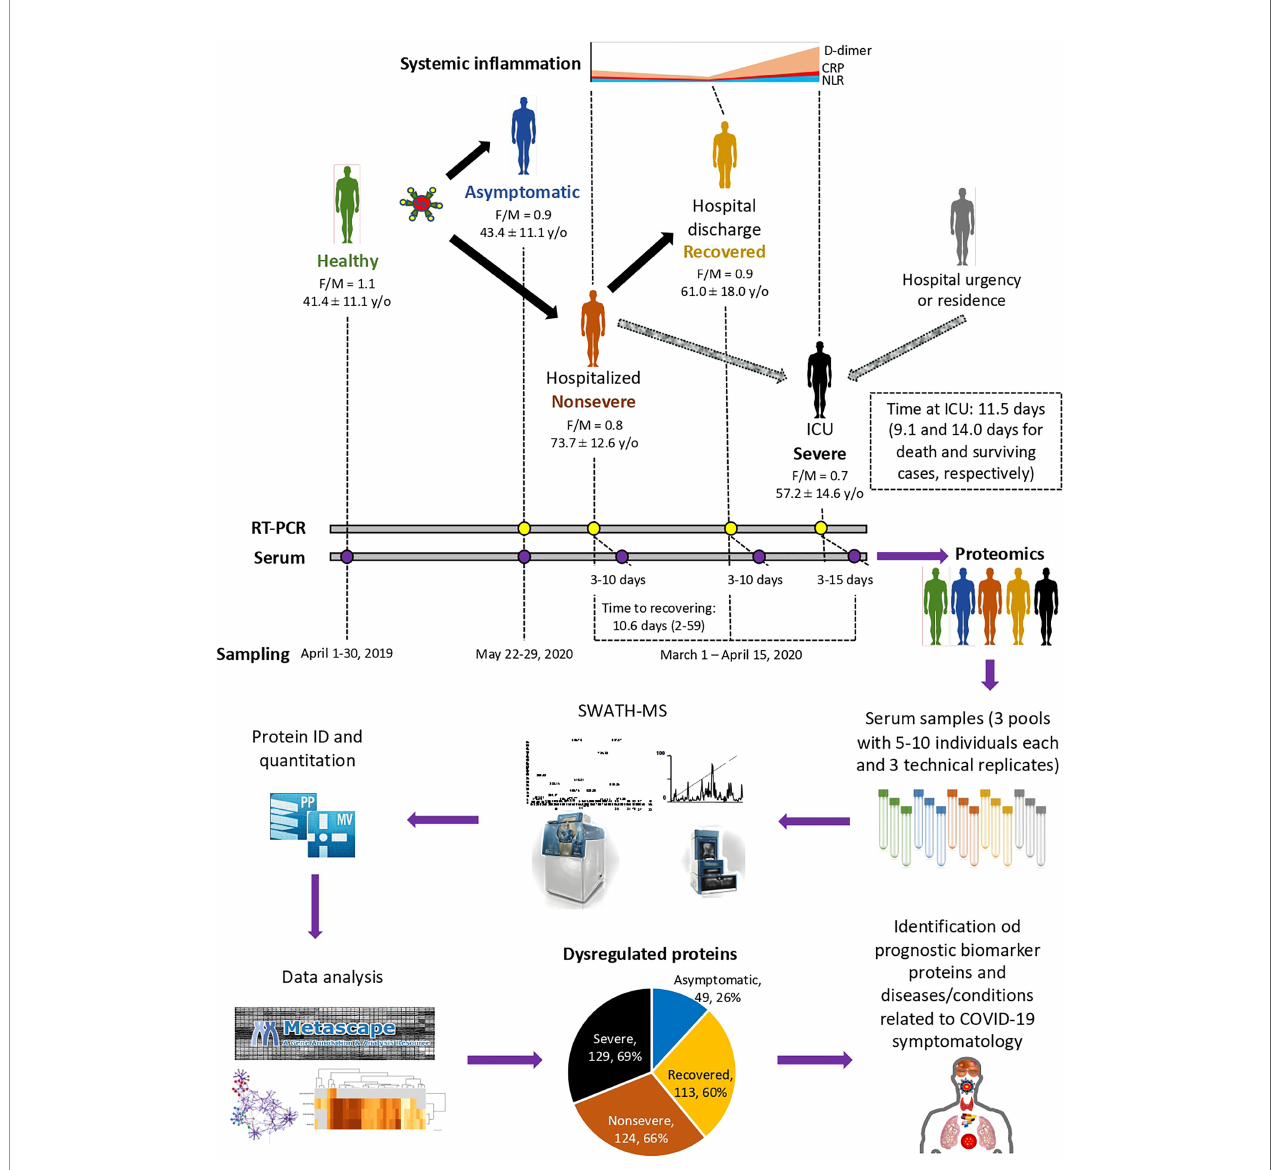
FIGURE 1 | Individual cohorts and study design. COVID-19 patients included cohorts of asymptomatic ( n = 16), recovered (hospital discharge; n = 26), nonsevere (hospitalized; n = 28), and severe (ICU; n = 25) cases with increasing systemic in fl ammation. Healthy individuals sampled before the COVID-19 pandemic were included in the analysis ( n = 25). Female-to-male (F/M) ratio and average ± S.D. age (y/o) are shown. Additional information can be found in Urra et al. (28). A SWATH-MS proteomics approach was used for data acquisition and analysis. A retrospective case – control study was conducted in patients suffering from COVID- 19 and healthy controls sampled at indicated dates using standard procedures. Serum from three pools of 5 – 10 individuals each with three technical replicates were used for proteomics using SWATH-MS protein identi fi cation and quantitation and data analysis using Metascape and networks of interactions between proteins and BPs using Graph Theory algorithms to identify dysregulated proteins in response to